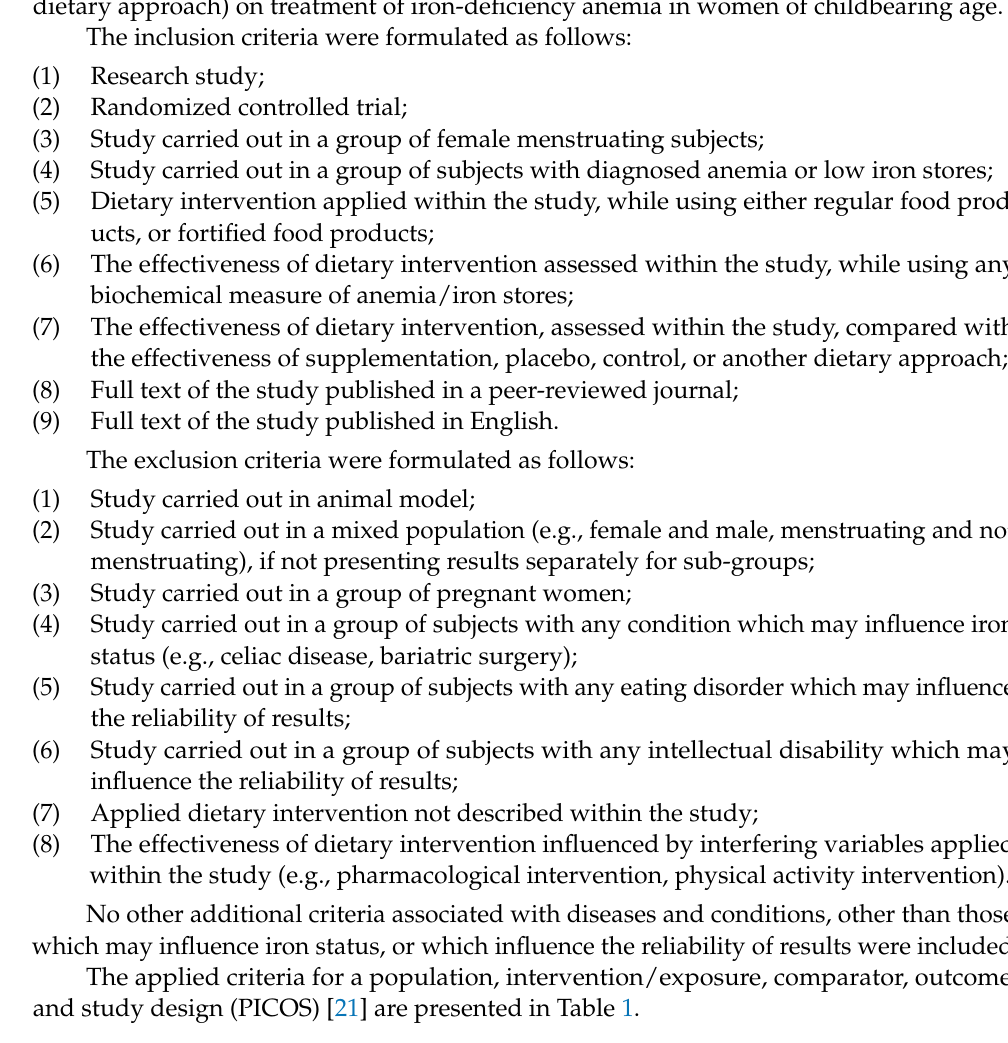
Table 1. The applied criteria for a population, intervention/exposure, comparator, outcome, and study design